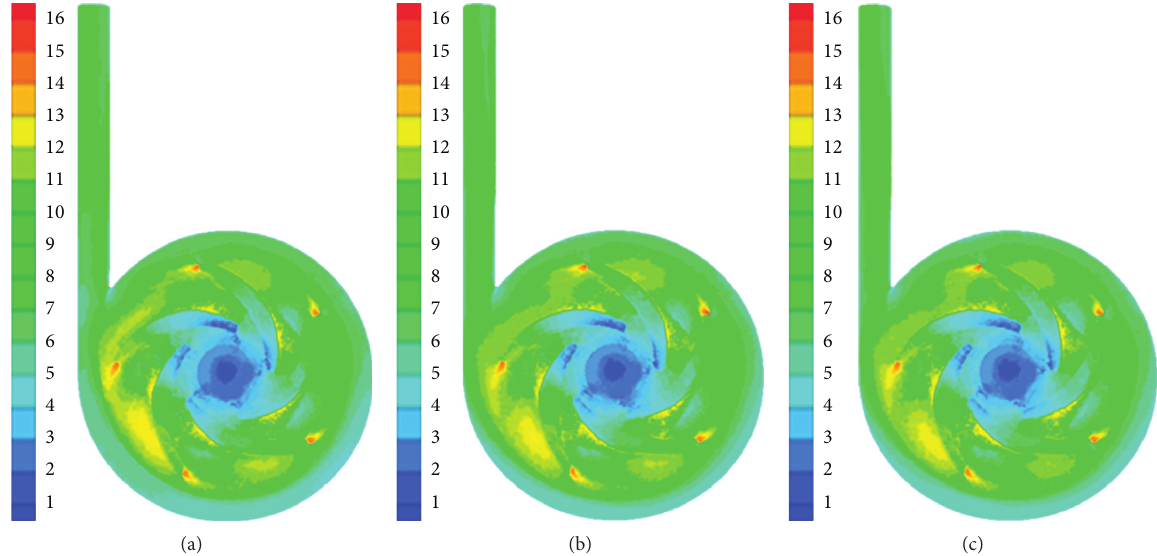
Figure 6: Cloud diagram of centrifugal pump velocity with different particle sizes ( C